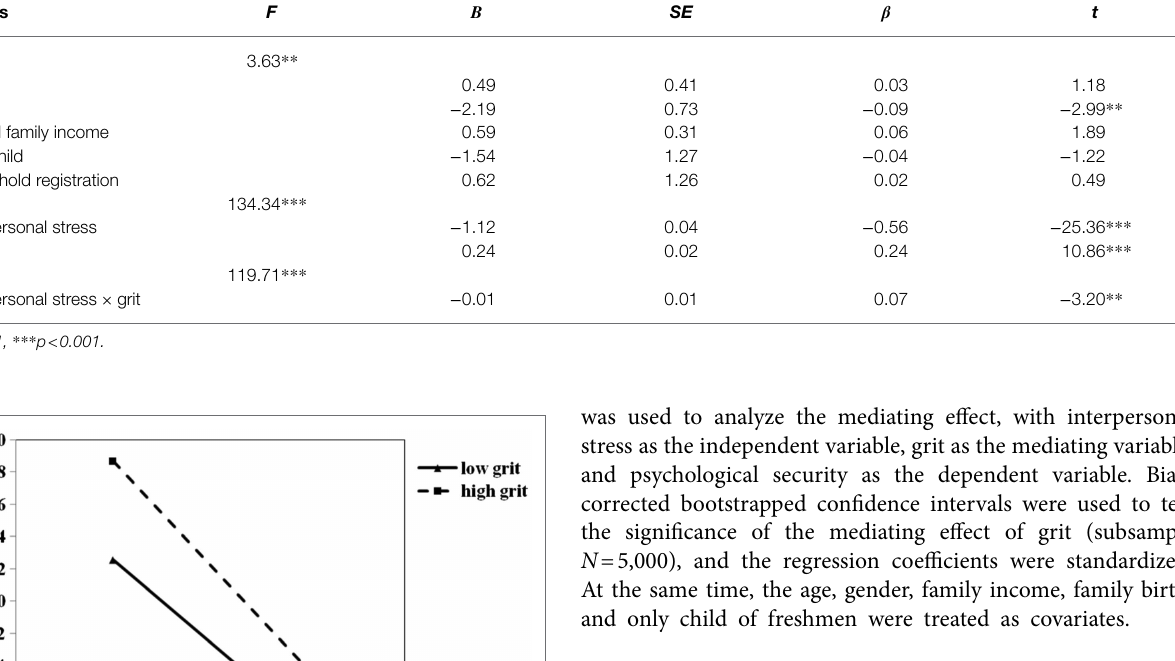
TABLE 2 | Analysis of the moderating effect of grit on interpersonal stress and psychological security in Study 1. Variables F В